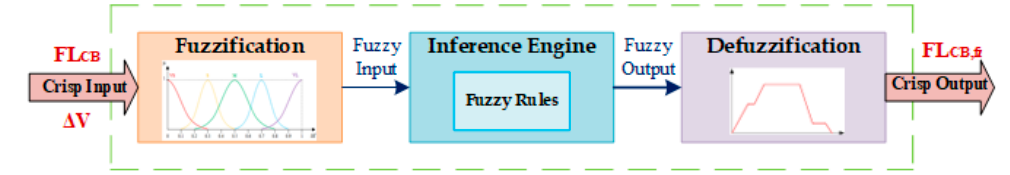
Figure 3. Fuzzy inference system. Table 1. Fuzzy rules for the calculation of the building clusters’ flexibility ( FL CB , fz